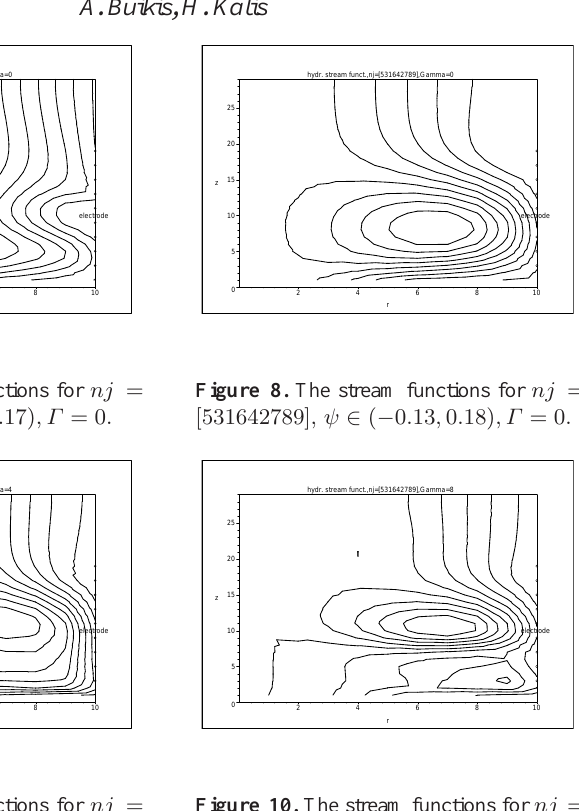
Figure 9. The stream functions for nj = [531642789] , ψ ∈ ( − 0 . 05 , 0 . 18) , Γ = 4 .